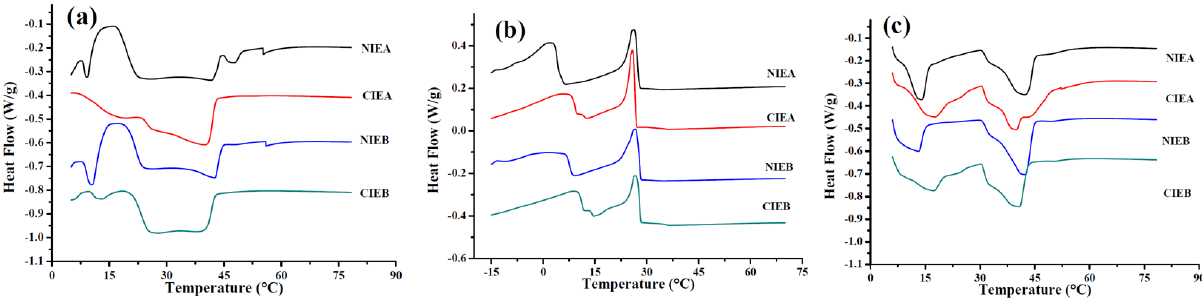
Figure 3. DSC curve of four ISMs, melting curve ( a ) and crystallization curve ( b ), re-melting curve ( c ).